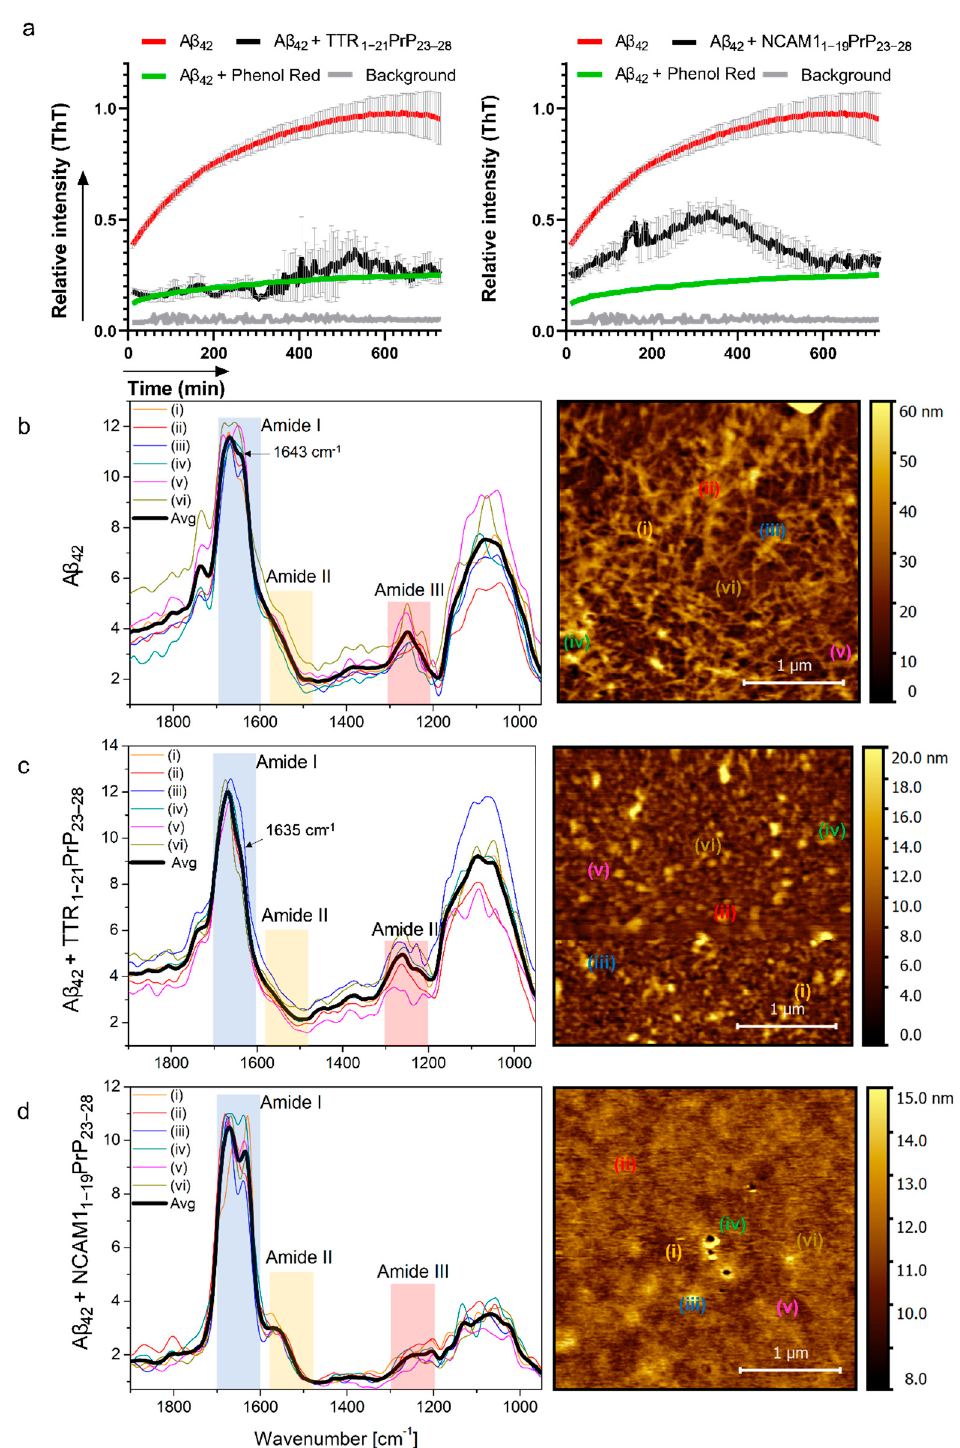
Figure 2. Assessment of the reduction in the aggregation of the A β 42 . ( a ) For detection of A β 42 aggregates Thioflavin T-based assay was used. 1:1 ratio of A β 42 to the peptide was used for these experiments. Results are normalized to the max intensity in the free A β 42 group. Inhibition control phenol red was added at a 100 µ M final concentration. Background control samples included ThT in water, ThT in buffer, and water or buffer without ThT. ( b ) AFM-infrared data from A β 42 aggregation in ( Α β 42 ) the absence, and in the ( c ) presence of ( Α β 42 + TTR 1 – 21 PrP 23 – 28 ) TTR 1-21 PrP 23-28 and ( d ) ( Α β 42 + NCAM1 1 – 19 PrP 23 – 28 ) NCAM1 1 – 19 PrP 23 – 28 amyloid inhibitors. The infrared spectra data have been collected from the area underneath the points numbered in the corresponding height images.